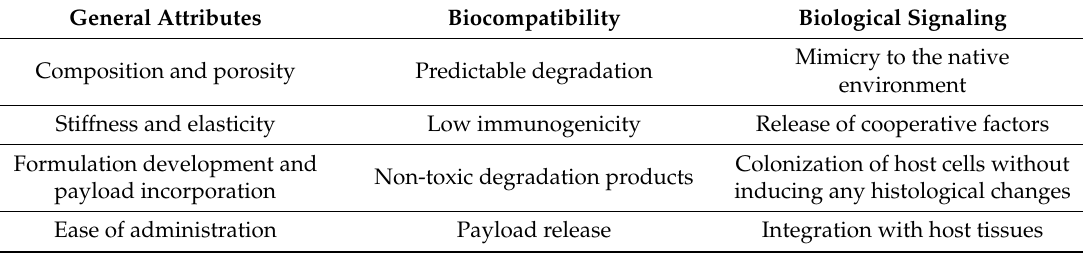
Table 1. Summary of important parameters for tissue scaffold